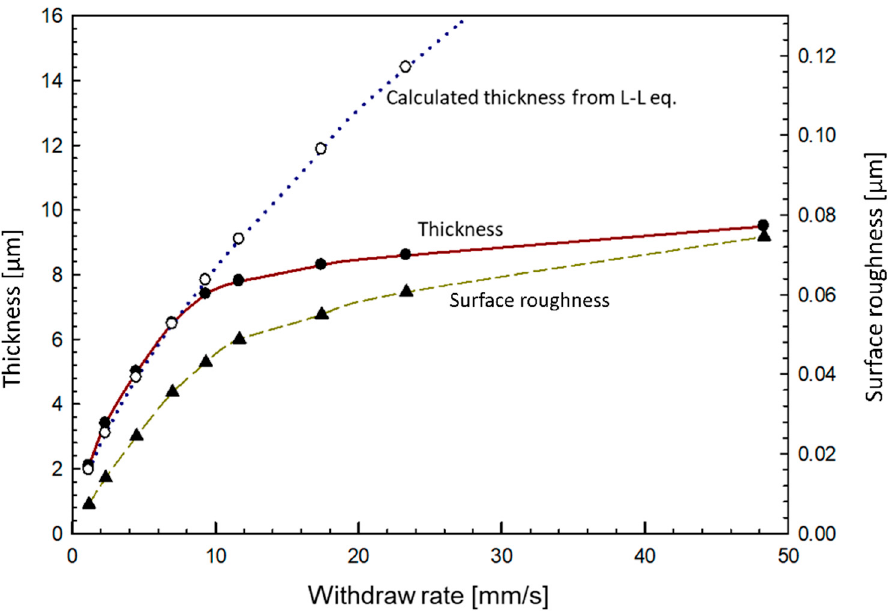
Figure 8. Graph of thickness and surface roughness (expressed as arithmetic mean height S a ) dependence on the withdrawal rates during the dip-coating procedure. The graph does not present the point for the calculated thickness at 48 mm/s. Coatings were deposited on structural steel and cured at 180 °C.